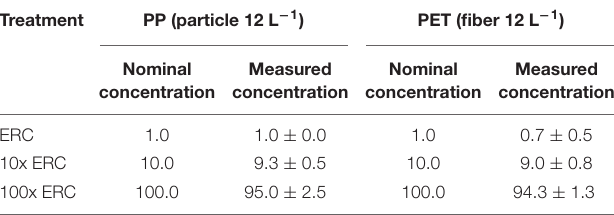
TABLE 2 | Nominal (1, 10, or 100 particles or fibers 12 L − 1 ) and measured (mean ± standard deviation) concentrations of microplastics in three treatment groups during single exposure of adult damselfish Pomacentrus amboinensis to blue polypropylene (PP) particles and polyester (PET) fibers in our controlled laboratory